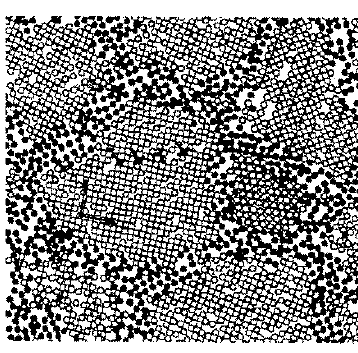
Figure 4. Nanopolycrystal structure.